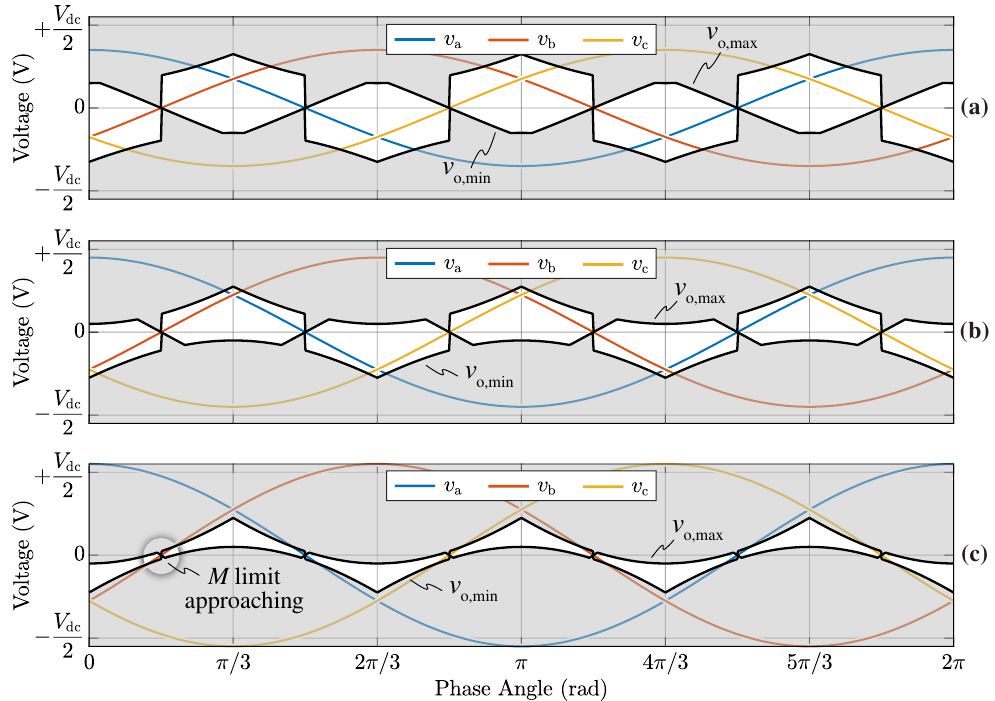
Figure 4. Zero-sequence voltage limits v o,max , v o,min for M = 0.7 ( a ), M = 0.9 ( b ) and M = 1.1 ( c ) assuming unity power factor operation ( ϕ = 0, i.e., sign ( i x ) = sign ( v x ) ).